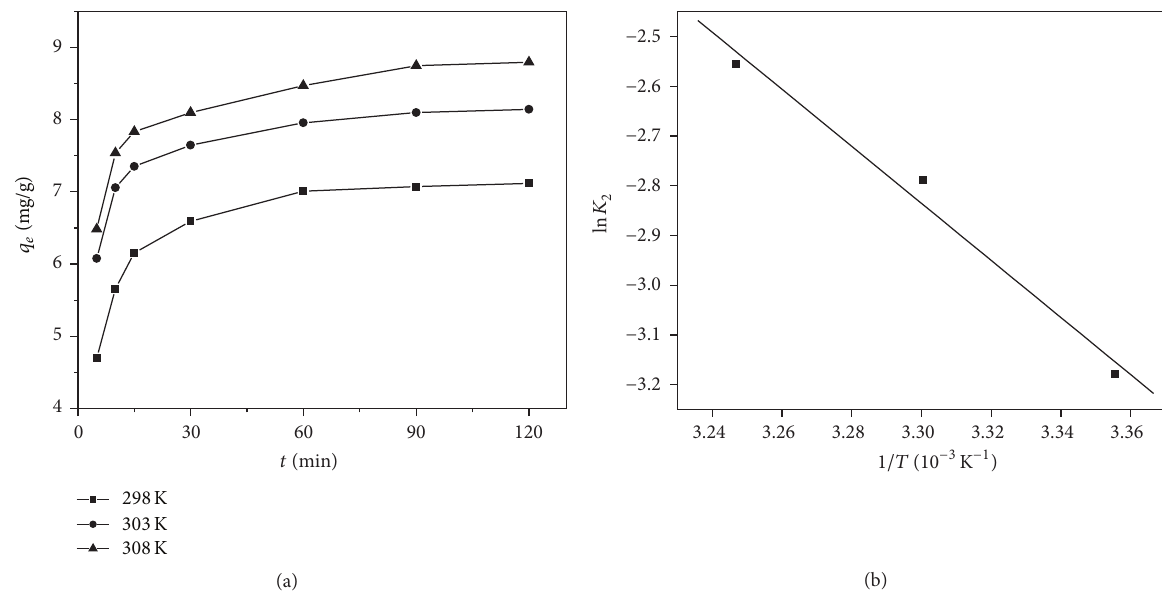
Figure 8: The activation energy of ammonia adsorption on X/AC (a) and plot of ln 𝑘 versus 1/ T